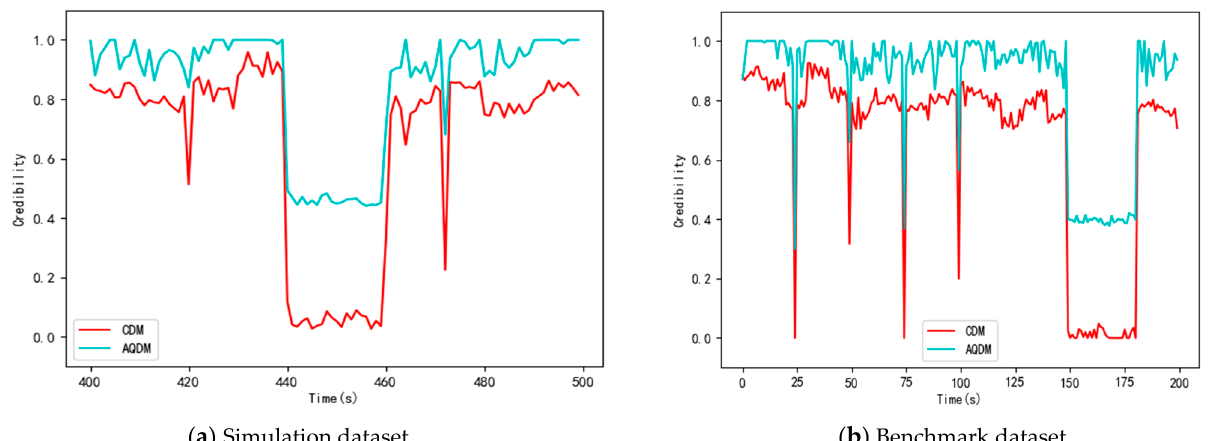
Figure 16. Data visualization. ( a ) Interfered data. ( b ) Data from neighboring sources.